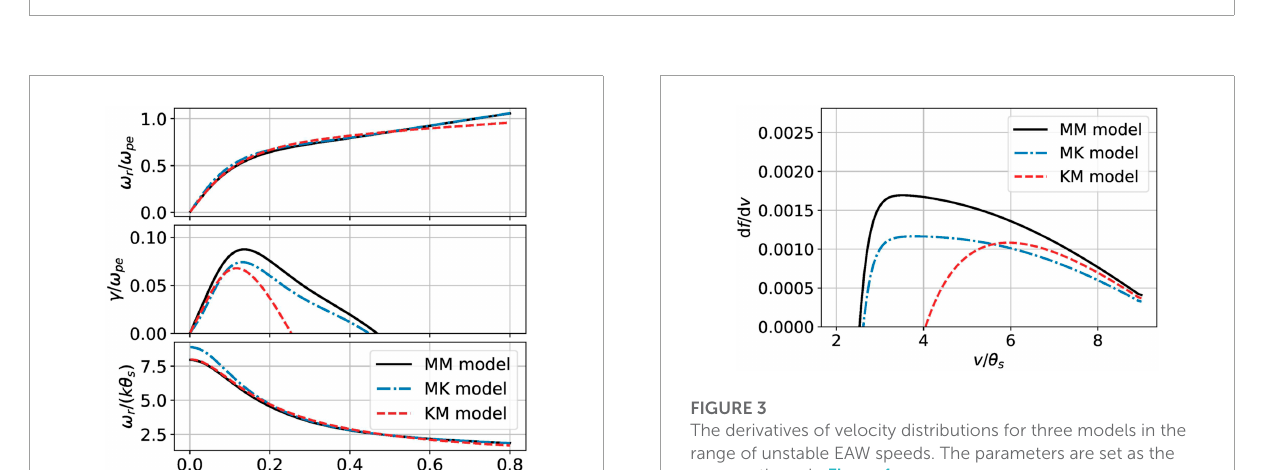
FIGURE 1 The one-dimensional velocity distribution for MM, MK, and KM models. The parameters κ s = ∞ and κ f = 2 are set in MK model, while κ s = 2 and κ f = ∞ in KM model. For all three models, the MPSs are set as θ s = 0 . 1 and θ f = 1. The drift of fast-MPS species are u f / θ s = 10. The number densities are n